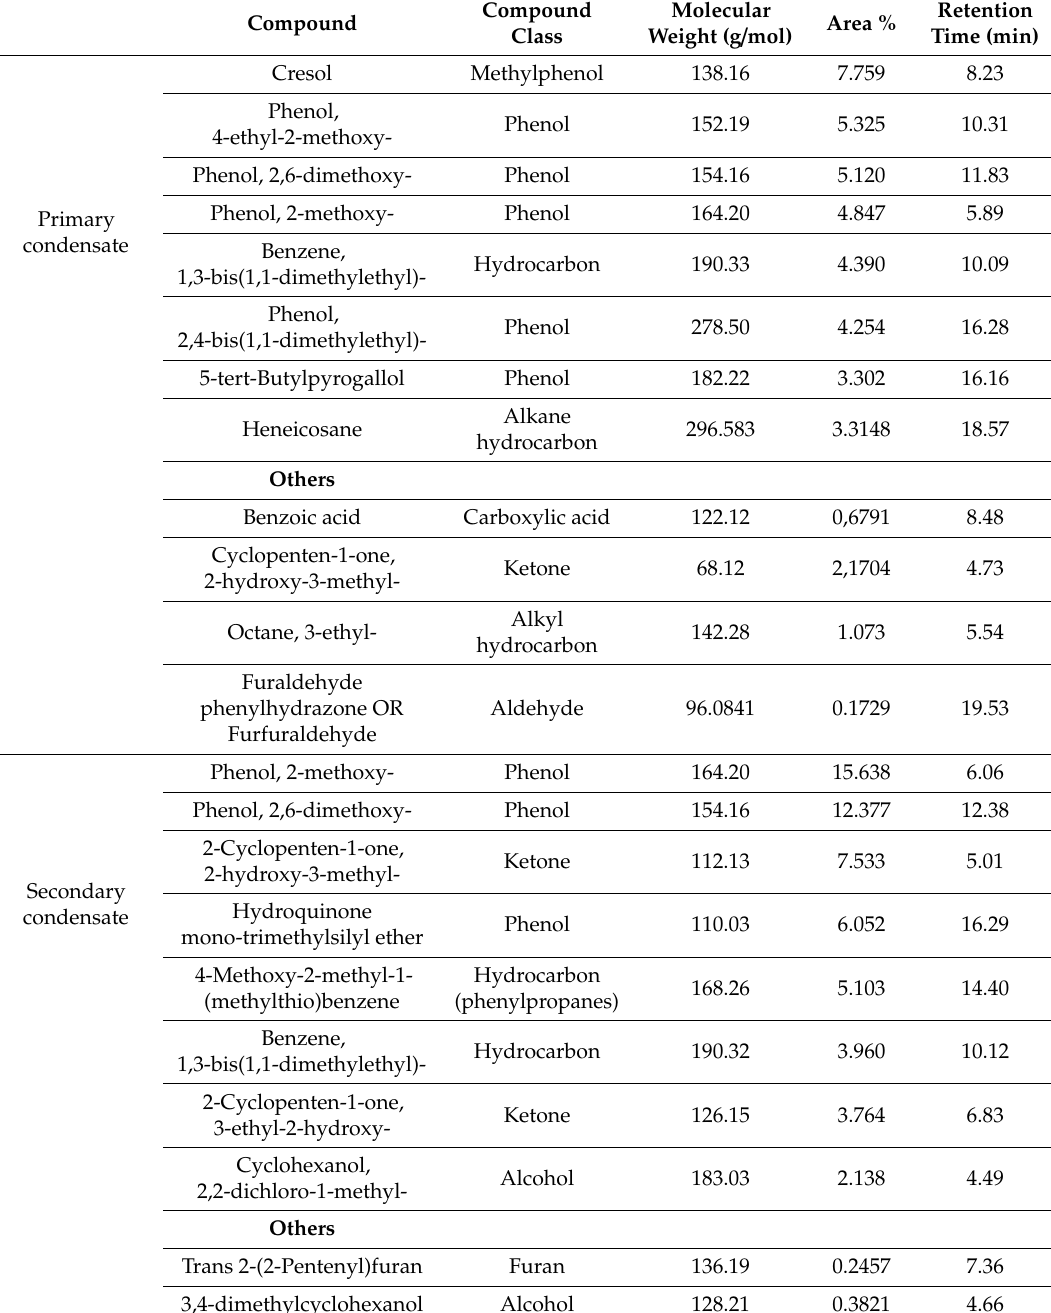
Table 5. GC–MS analysis for Acacia tortilis primary and secondary condensates obtained at optimal condition (primary condenser temp of 140 ◦